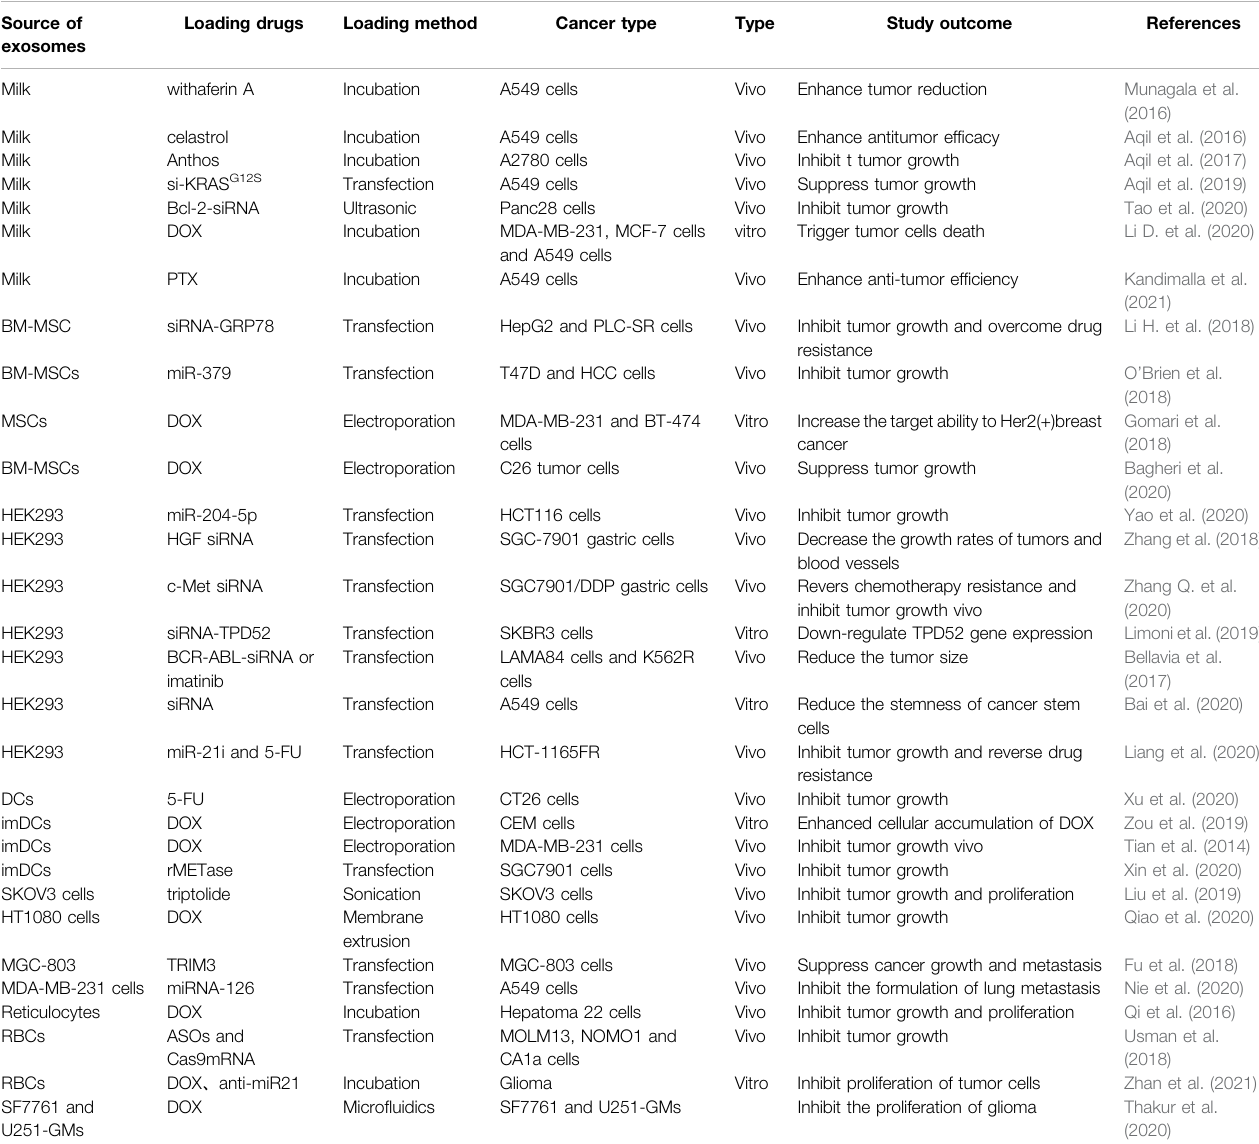
TABLE 1 | The summary of exosomes as drug carriers for cancer therapy. Source of